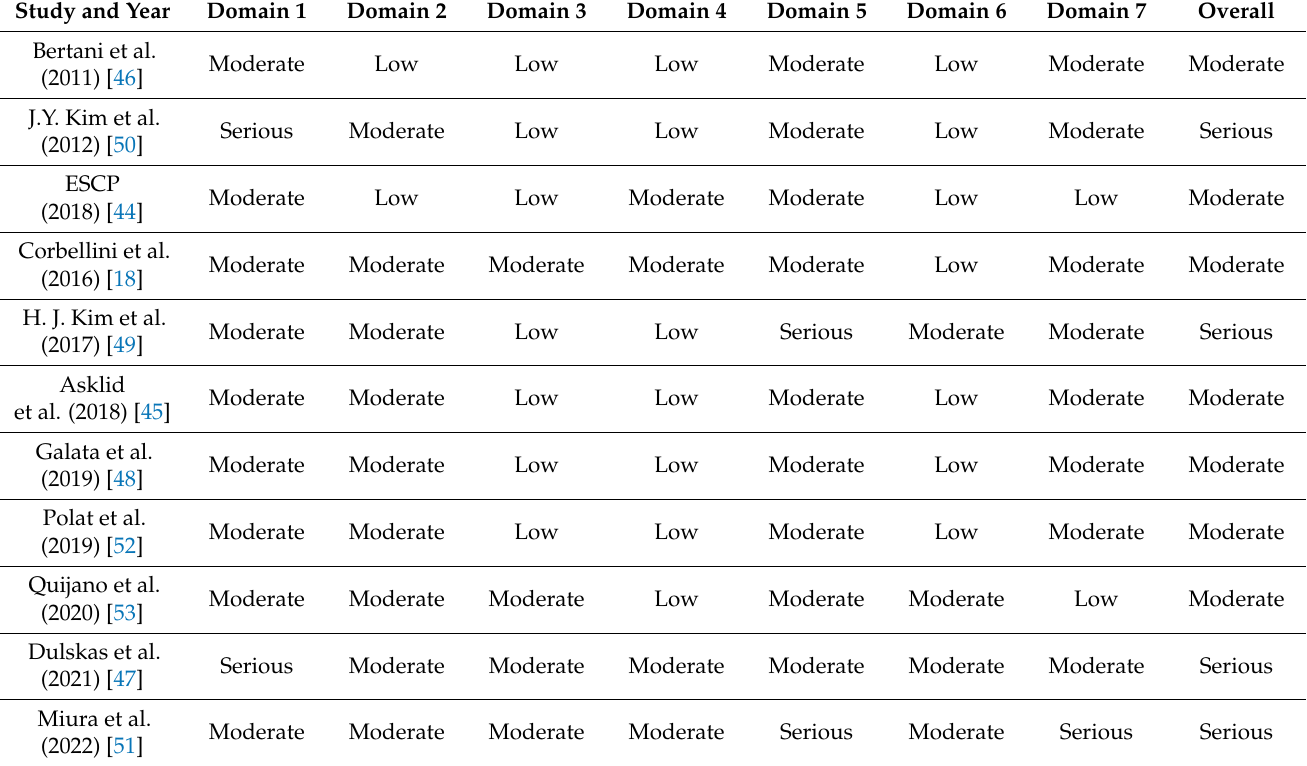
Table 3. Risk of bias assessment using ROBINS-I for non-randomized prospective